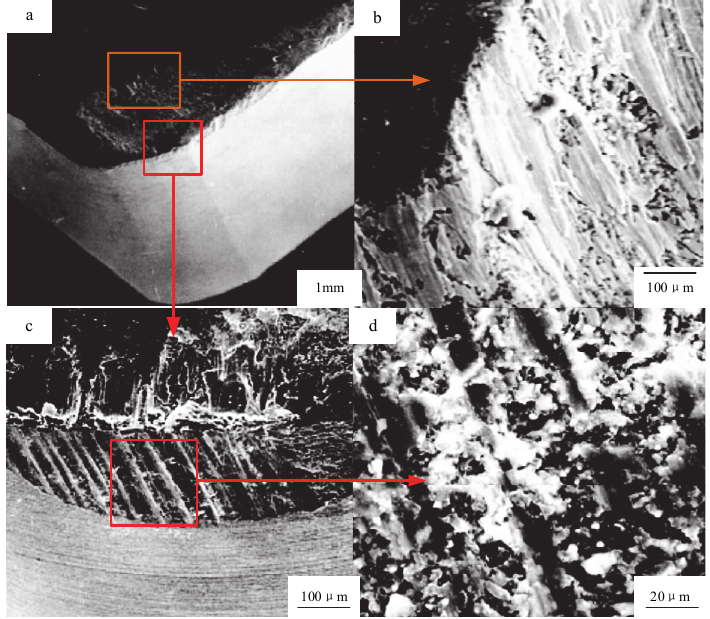
Figure 3. SEM micrographs of wear in Inconel 718 nickel-based alloys after machining with an ABW20 ceramic tool. (( b , c ) are partial enlarged views of ( a ); ( d ) is a partial enlarged view of ( c )) [19].